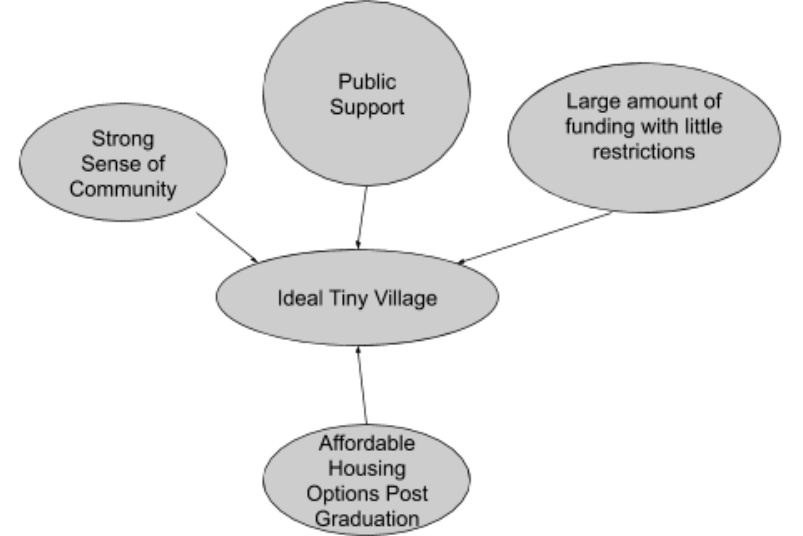
Figure 1. Key elements of an ideal tiny village.